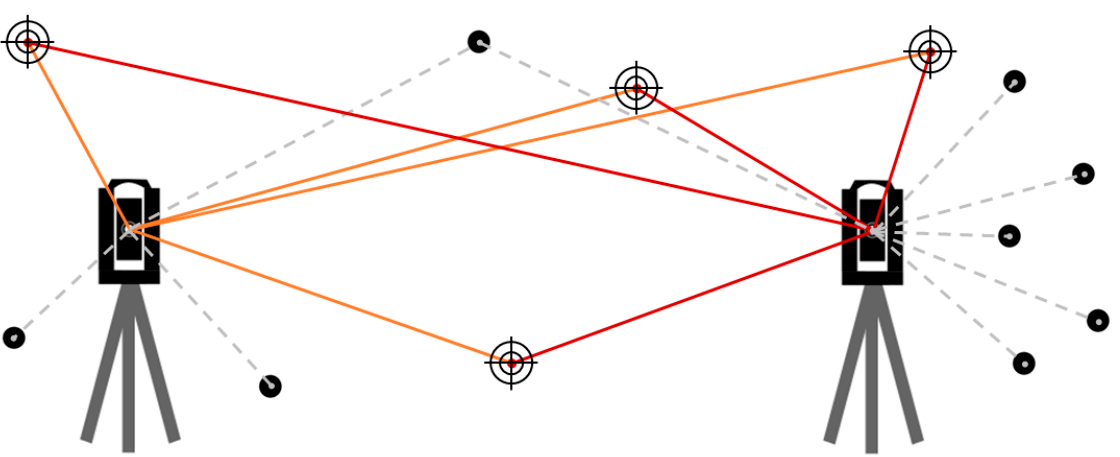
Figure 4. Local coordinate system with geodetic reference targets used for setting up the total stations (orange and red lines) to measure the Vicon retroreflective markers (grey dotted lines).